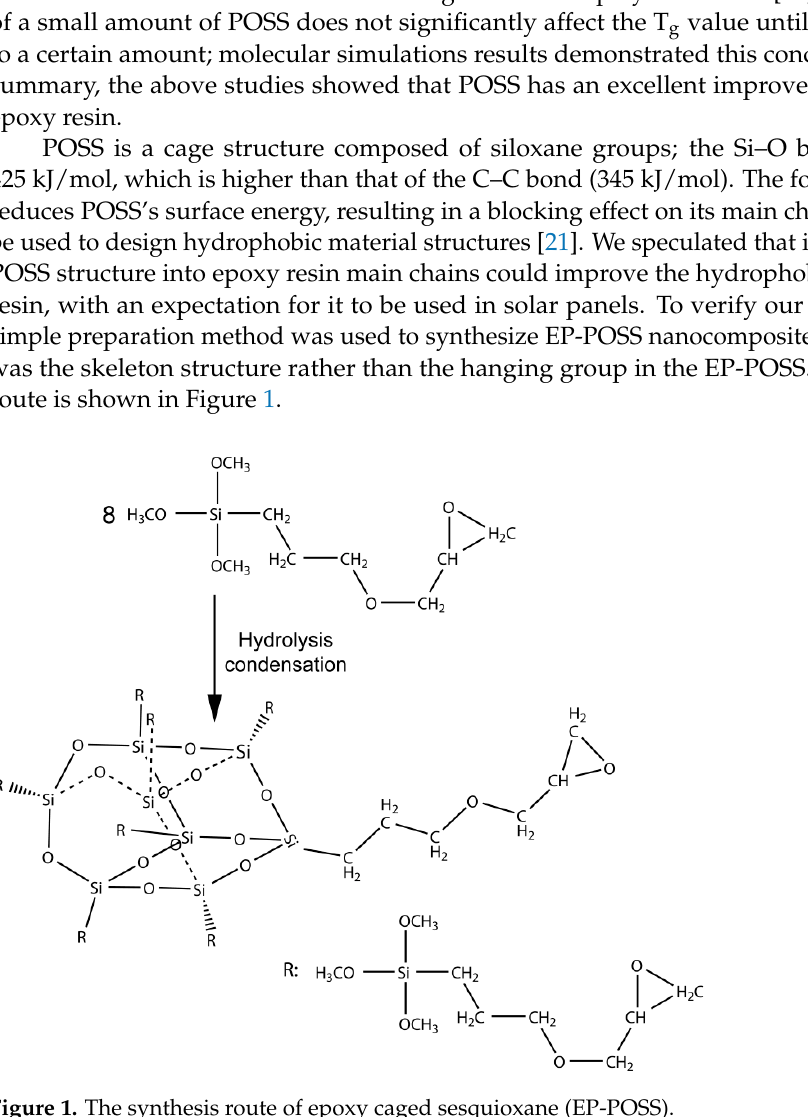
Figure 1. The synthesis route of epoxy caged sesquioxane